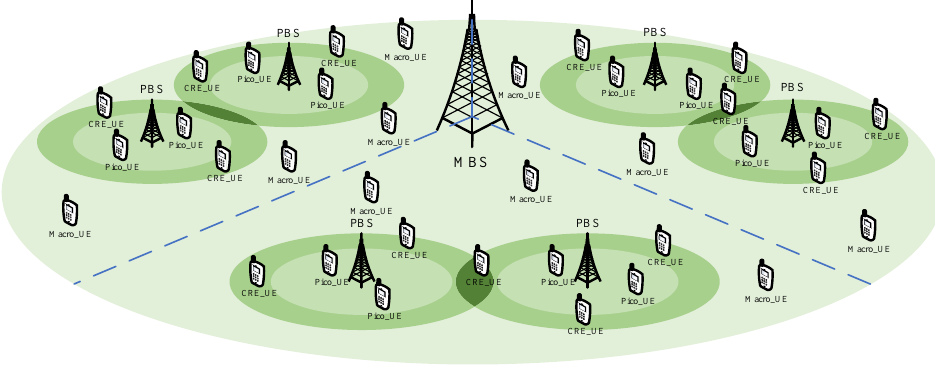
Figure 1. System